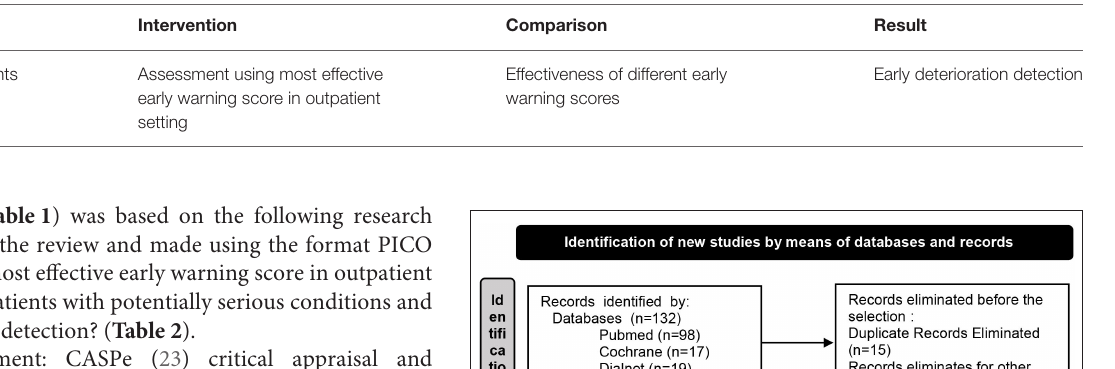
TABLE 2 | Research question in PICO format.